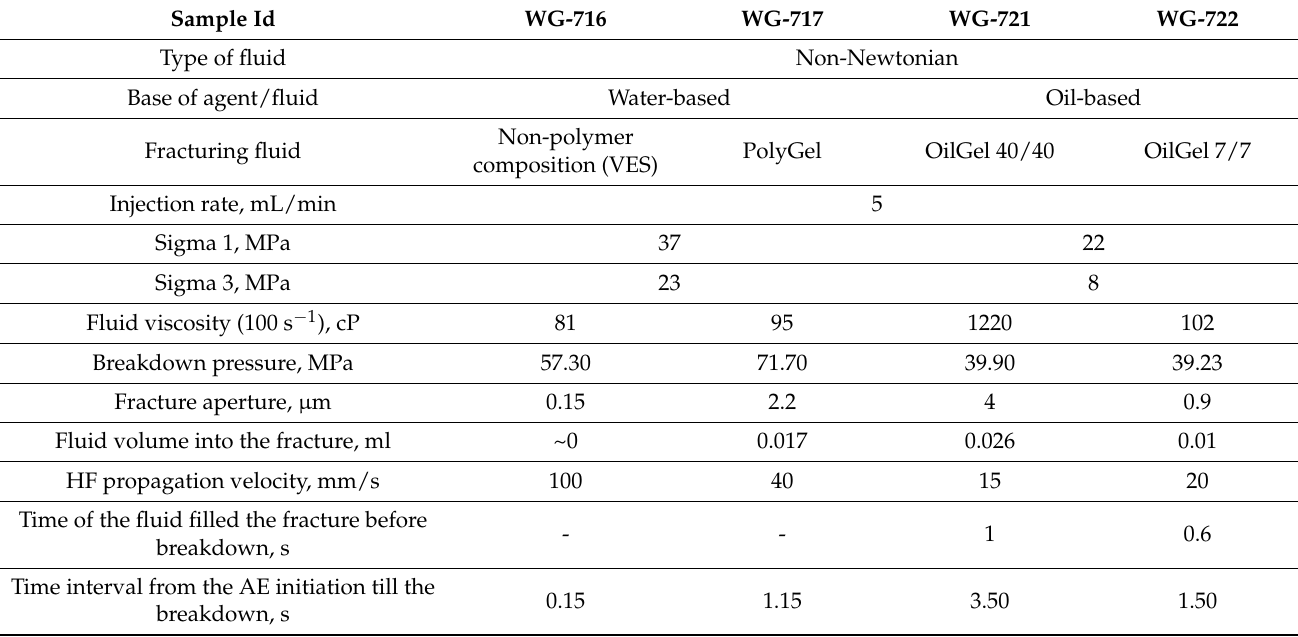
Table 5. Generalized results of geomechanical